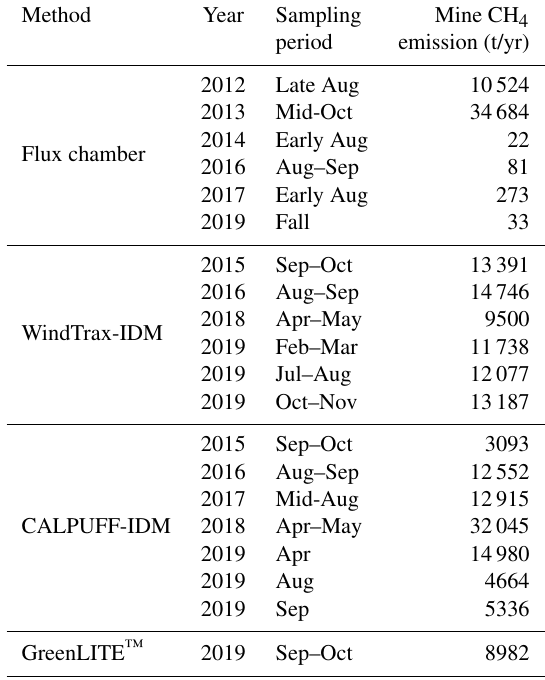
Table A1. Historical tailings pond emission studies (AECOM Canada Ltd., 2021).